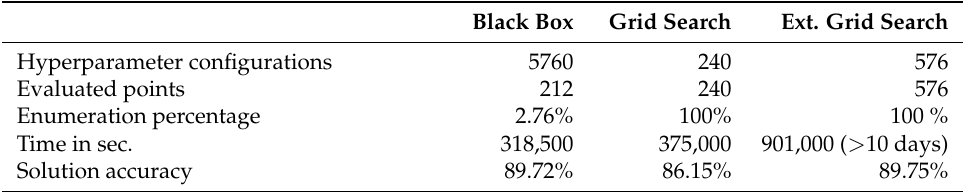
Table 1. Comparison of black-box optimization and 2 variants of grid search for CNN.